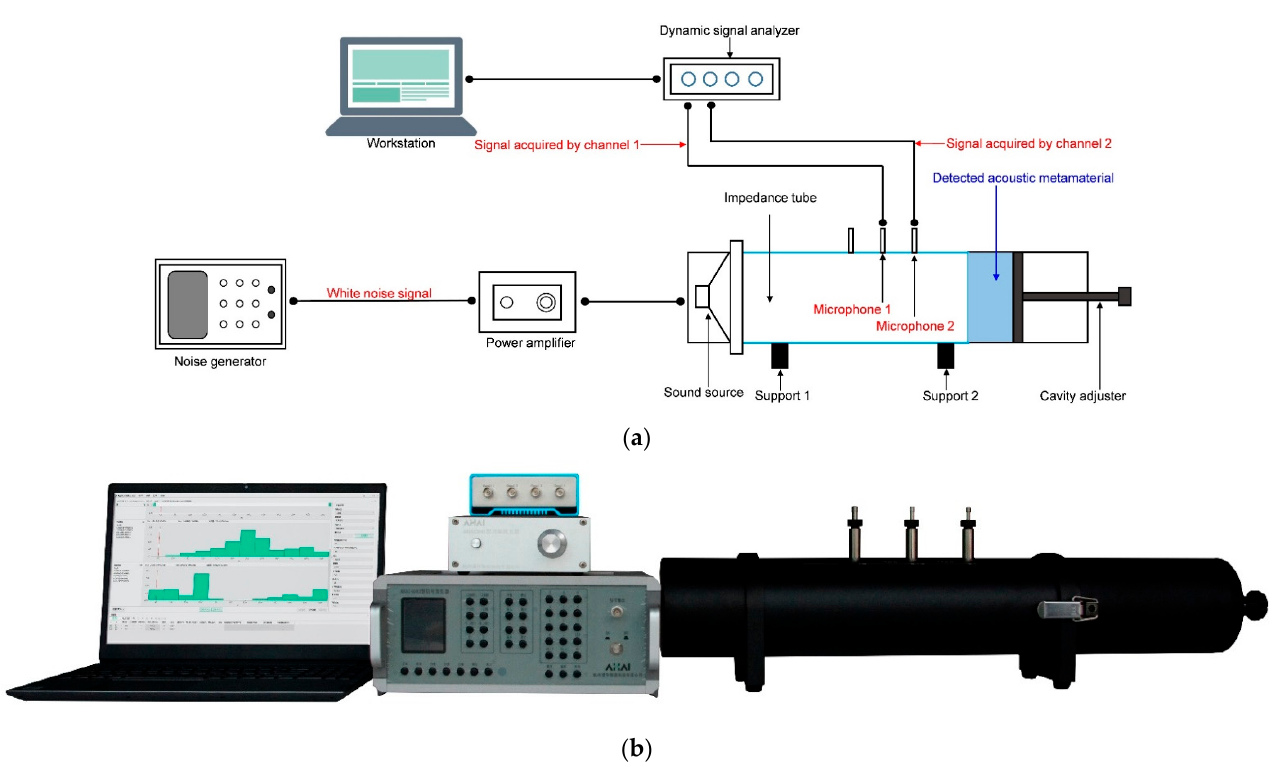
Figure 17. The sound absorption coefficient measurement. ( a ) Schematic diagram of measurement process; and ( b ) the actual image of AWA6290T transfer functional impedance detector.